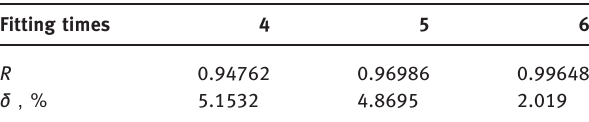
Table 3: Comparison of prediction accuracy of equation. Fitting